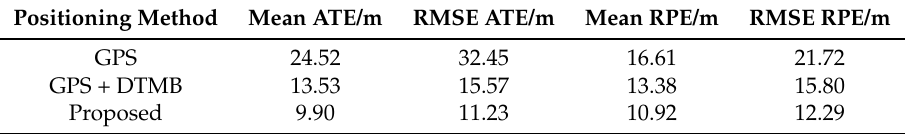
Table 4. Mean and RMSE values of ATE and RPE of different methods at Site 1.